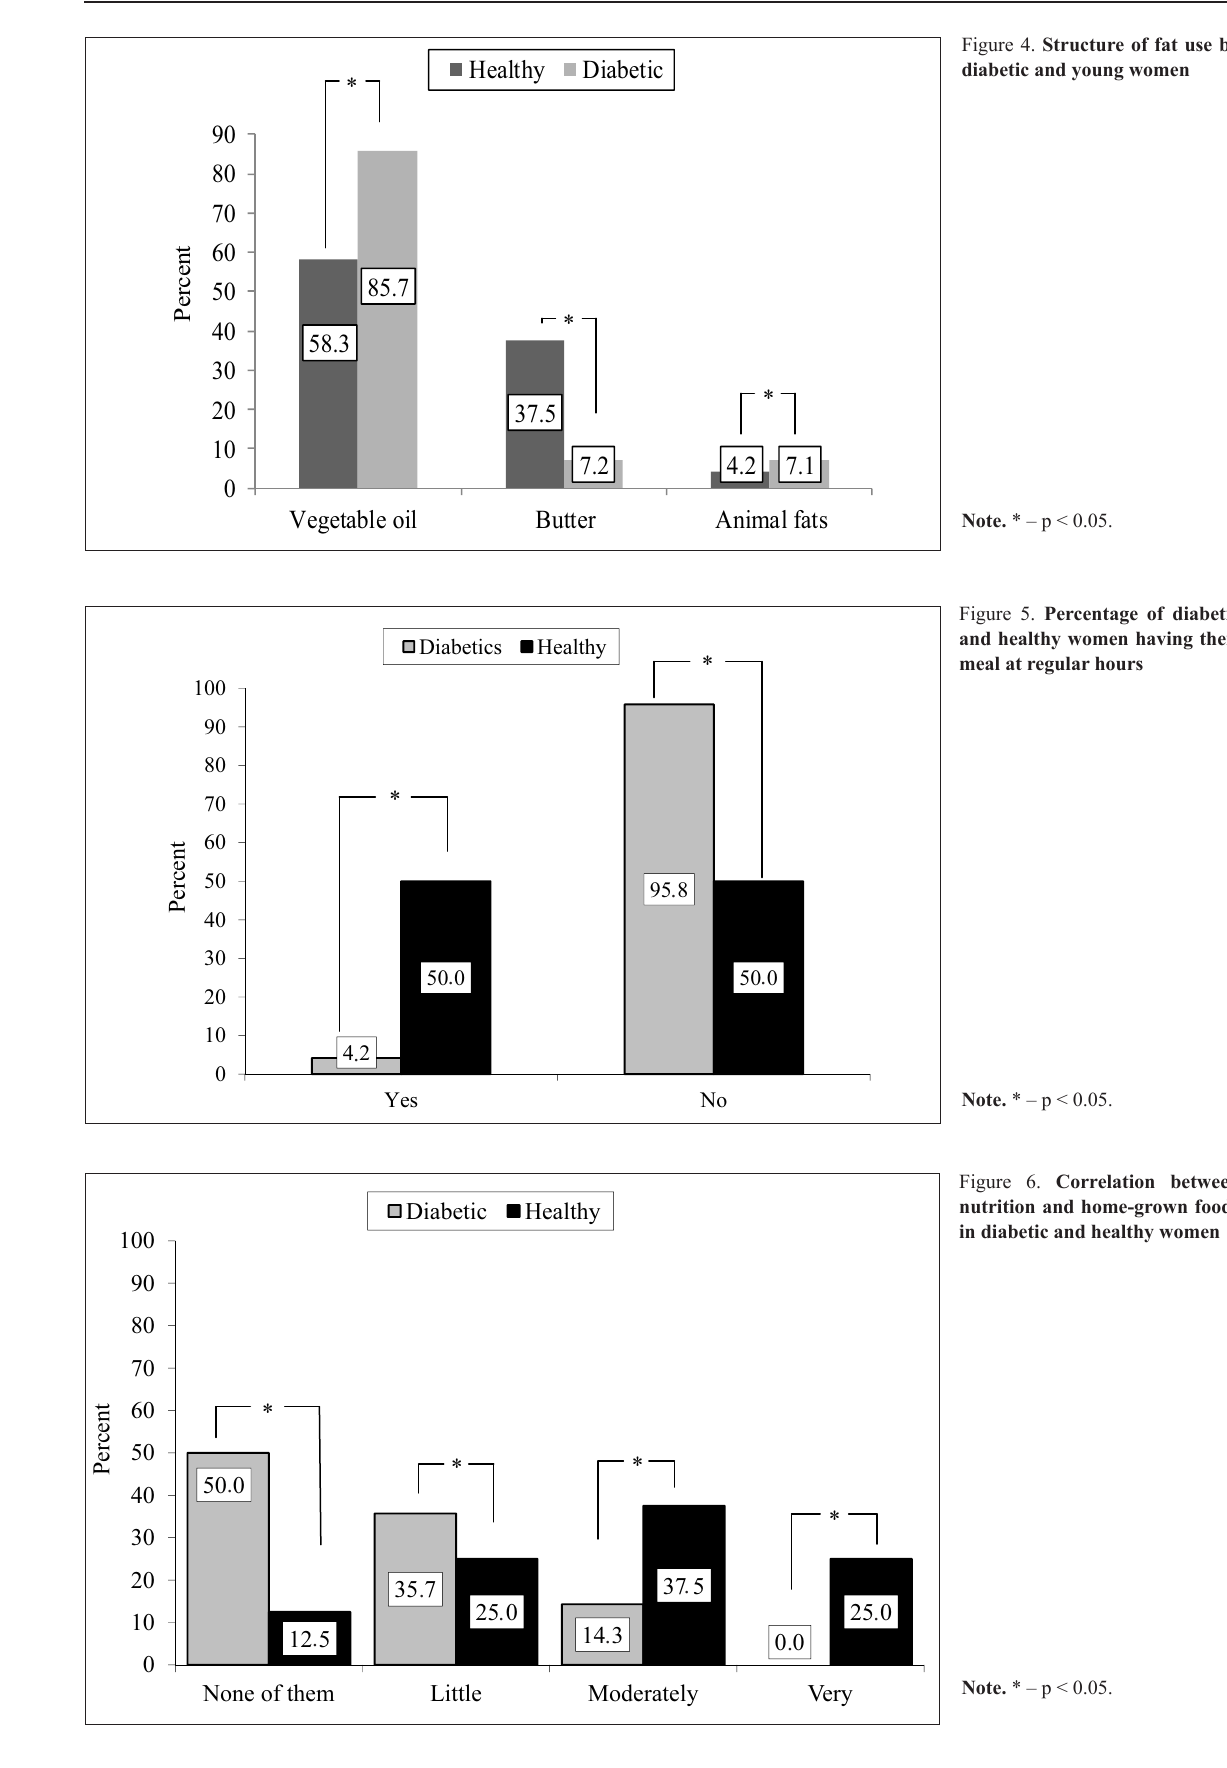
Figure 6. Correlation between nutrition and home-grown foods in diabetic and healthy